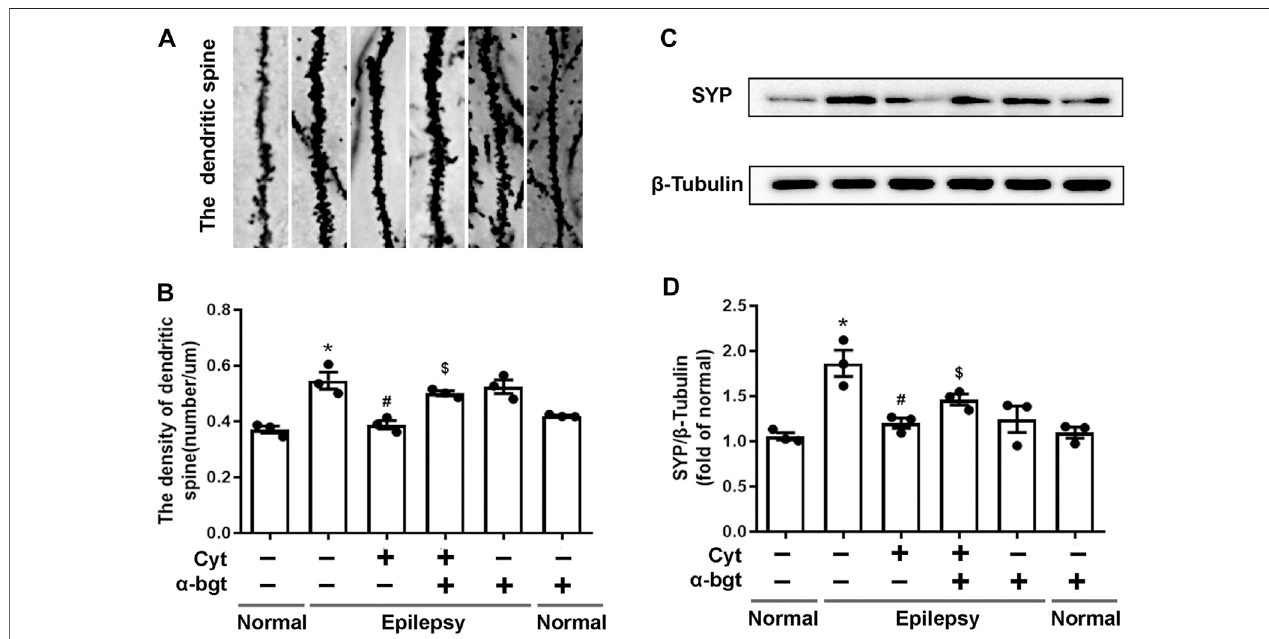
FIGURE 4 | Cytisine inhibits synaptic remodeling in the hippocampi of epileptic rats. A: Dendritic spines dyed by Golgi staining in the dentate gyrus of the hippocampus. B: Quantitative analysis of the densities of dendritic spines. Statistical results are as follows: F (5,12) (cid:1) 16.685, p < 0.05, n (cid:1) 3; normal vs. epilepsy, * p < 0.05; epilepsy vs. epilepsy + Cyt, # p < 0.05; epilepsy + Cyt vs. epilepsy + Cyt + α -bgt, $ p < 0.05. C – D: The expression of synaptophysin in the hippocampus was analyzed by Western blotting. Statistical results are as follows: F (5,12) (cid:1) 10.802, p < 0.05, n (cid:1) 3; normal vs. epilepsy, * p < 0.05; epilepsy vs. epilepsy +